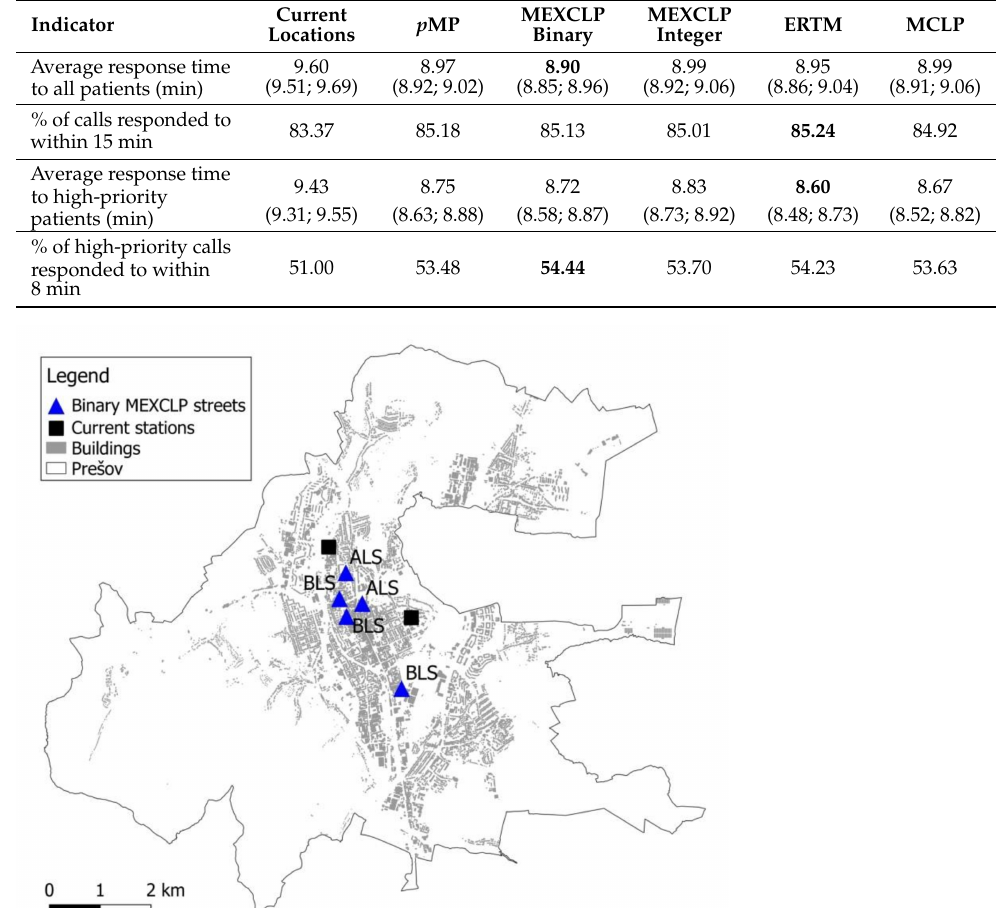
Table 6. Performance indicators for different distributions of the EMS stations in the district of Prešov, street model of demand.